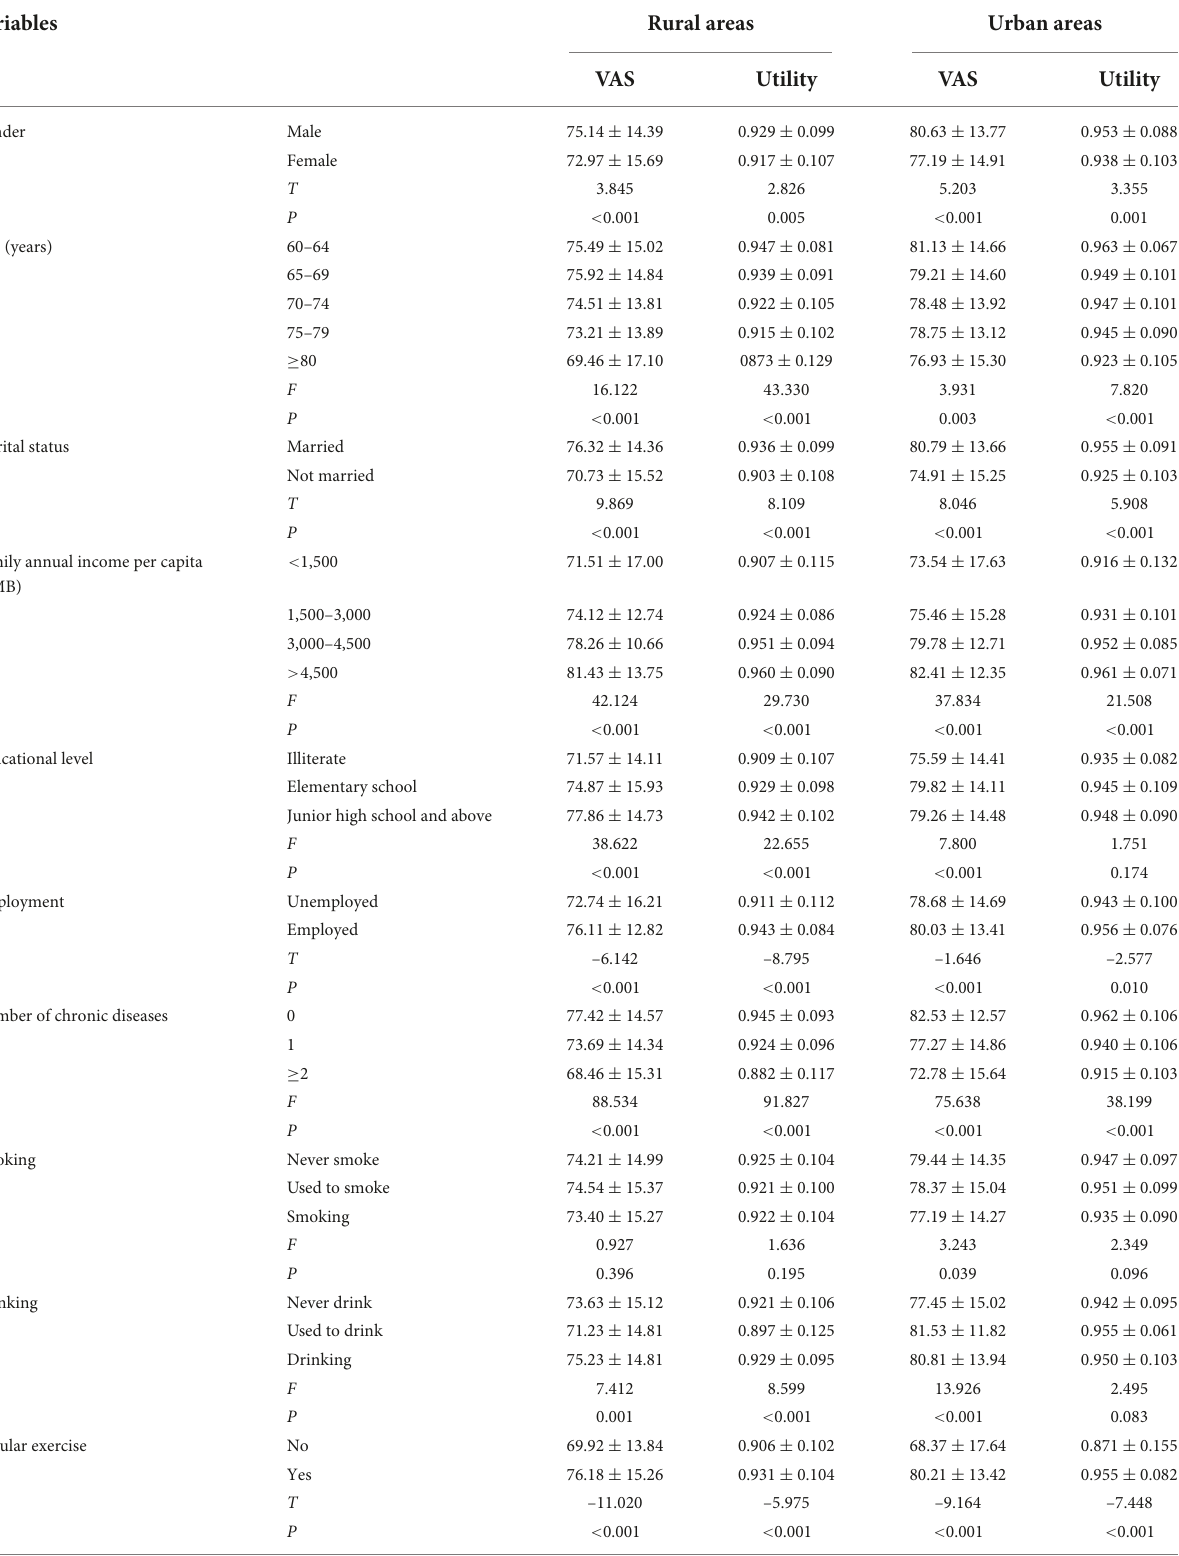
TABLE 4 Distribution of VAS scores and utility index among older people (Mean ±